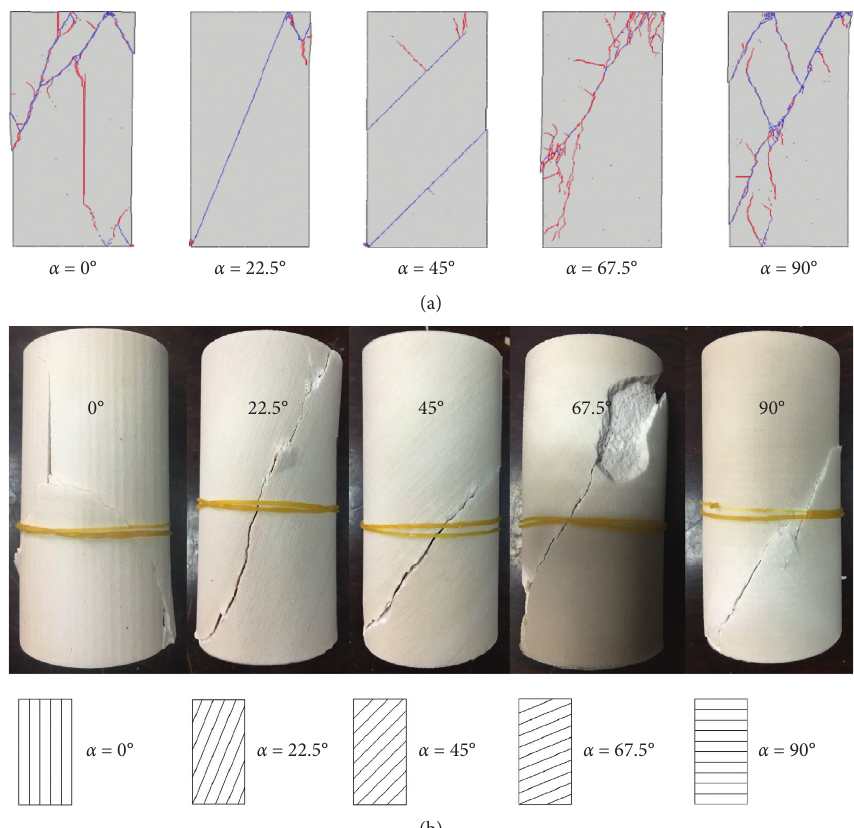
Figure 10: Comparison of simulated versus experimentally observed fracture patterns during UCS tests with different inclined angle α . (a) Failure patterns of simulated samples. (The blue curve in the figure represents tension failure, and the red represents shear failure.) (b) Failure patterns of 3D-printed samples.